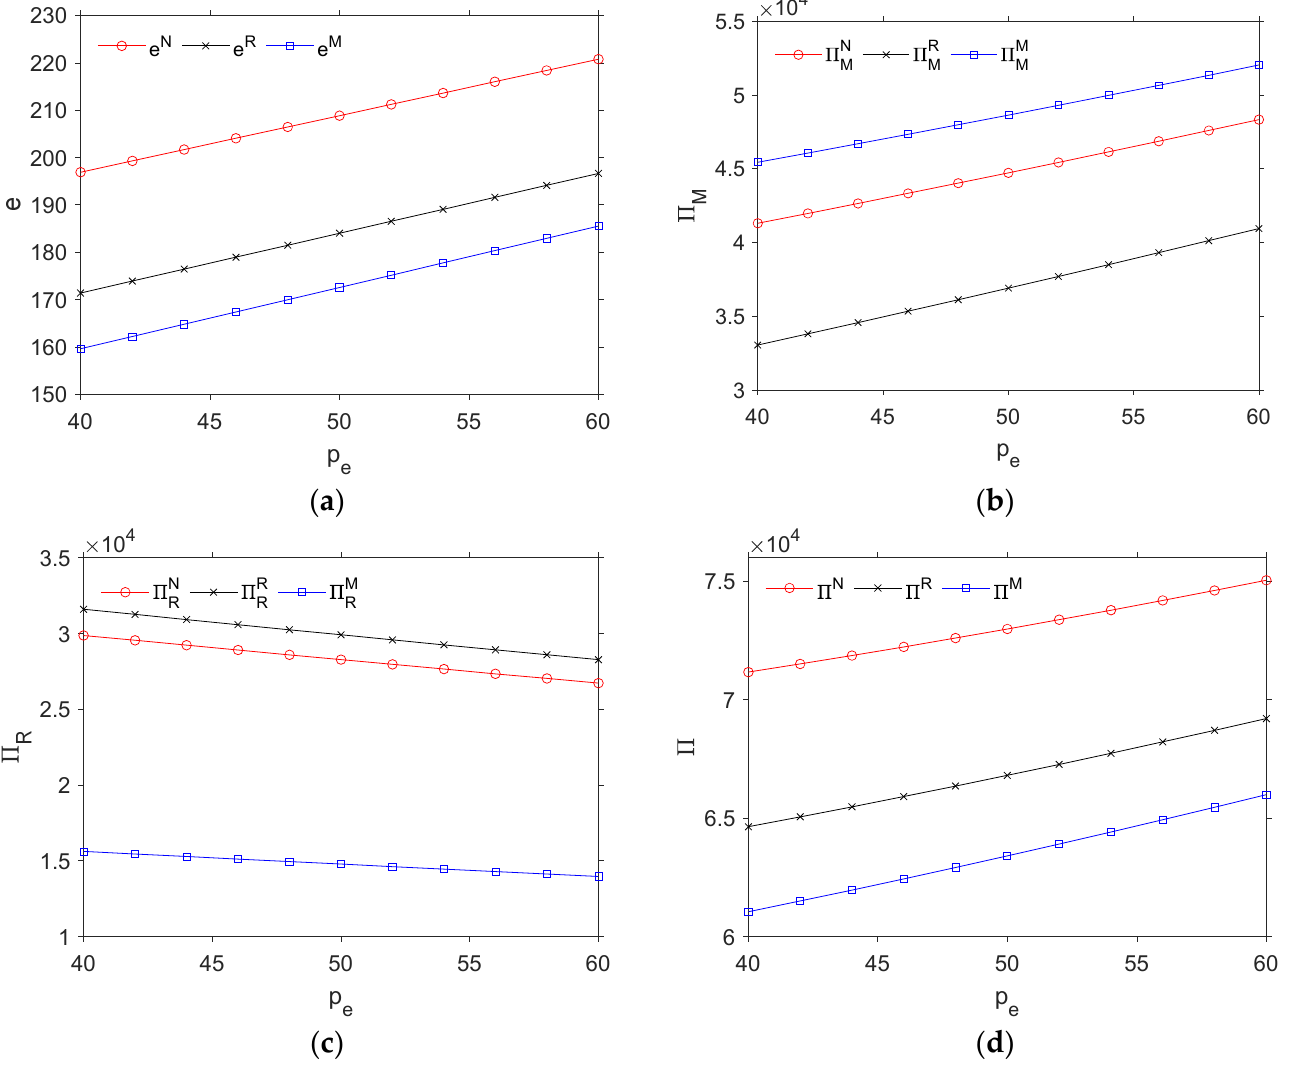
Figure 3. The changes in the supply chain profits ( b – d ) and carbon emissions reduction levels ( a ) that were caused by p e .